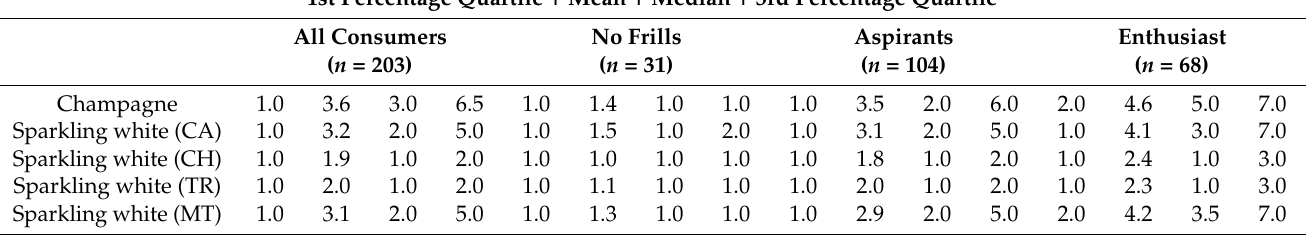
Table 6. Consumers’ and Fine Wine Instrument consumer segments’ knowledge of different sparkling wine produc- tion